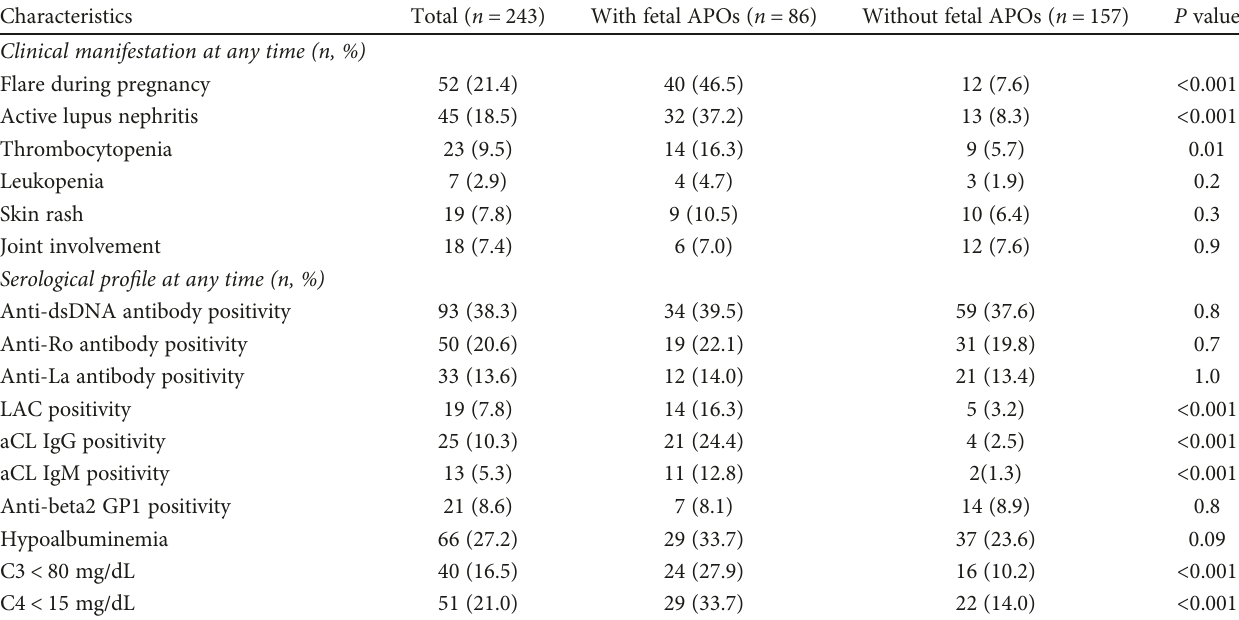
Table 2: Association of di ff erent characteristics during pregnancy with composite fetal APOs.